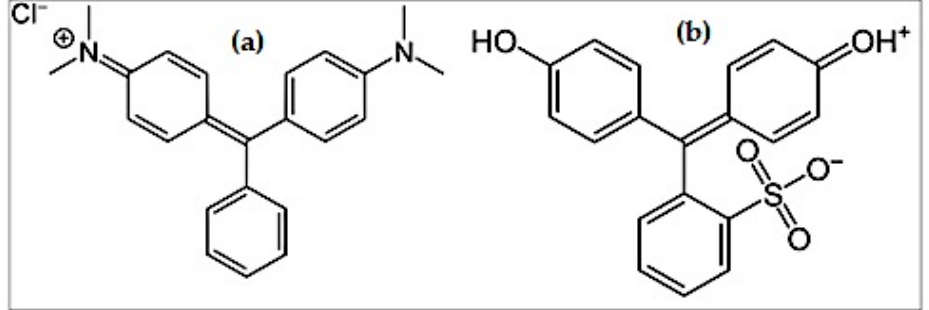
Figure 1. The chemical structure of dyes ( a ) malachite green carbinol and ( b ) x-phenol red.